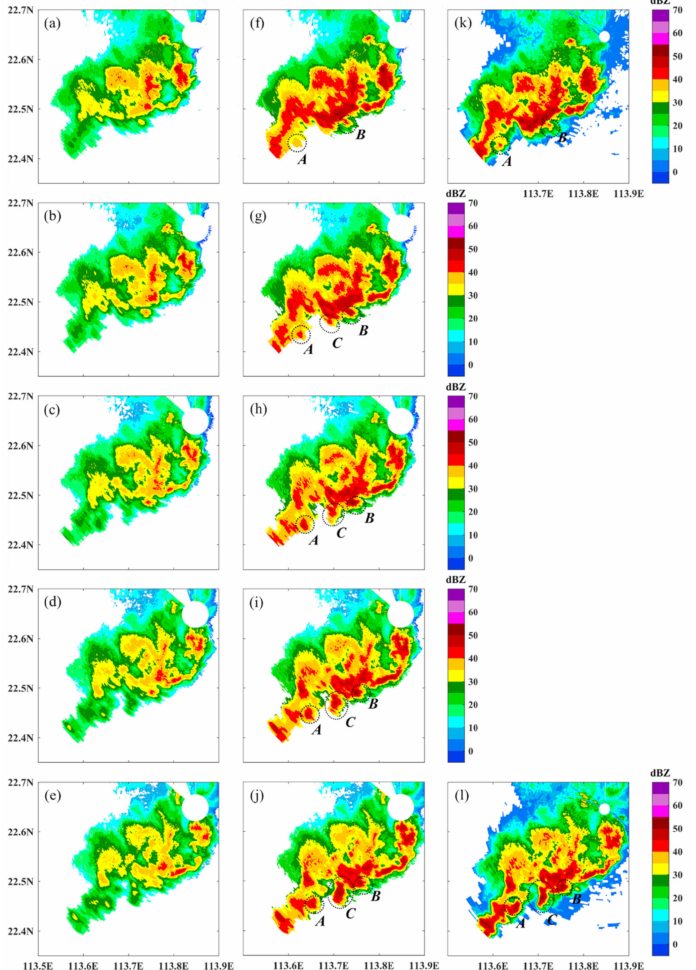
Figure 8. Reflectivity measured by X-PAR and S-POL from 01:44 to 01:50 (UTC) on 5 June 2020. ( a – e ) are Z H of X-PAR without attenuation correction at 01:44:32, 01:46: 04, 01:47:38, 01:49:10, and 01:50:42; ( f – j ) are Z H of X-PAR after attenuation correction; and ( k , l ) are Z SX ( Z H from S-POL and convert to X-PAR) at 01:42 and 01:48, respectively; A, B and C are three rapidly evolving cells in the precipitation